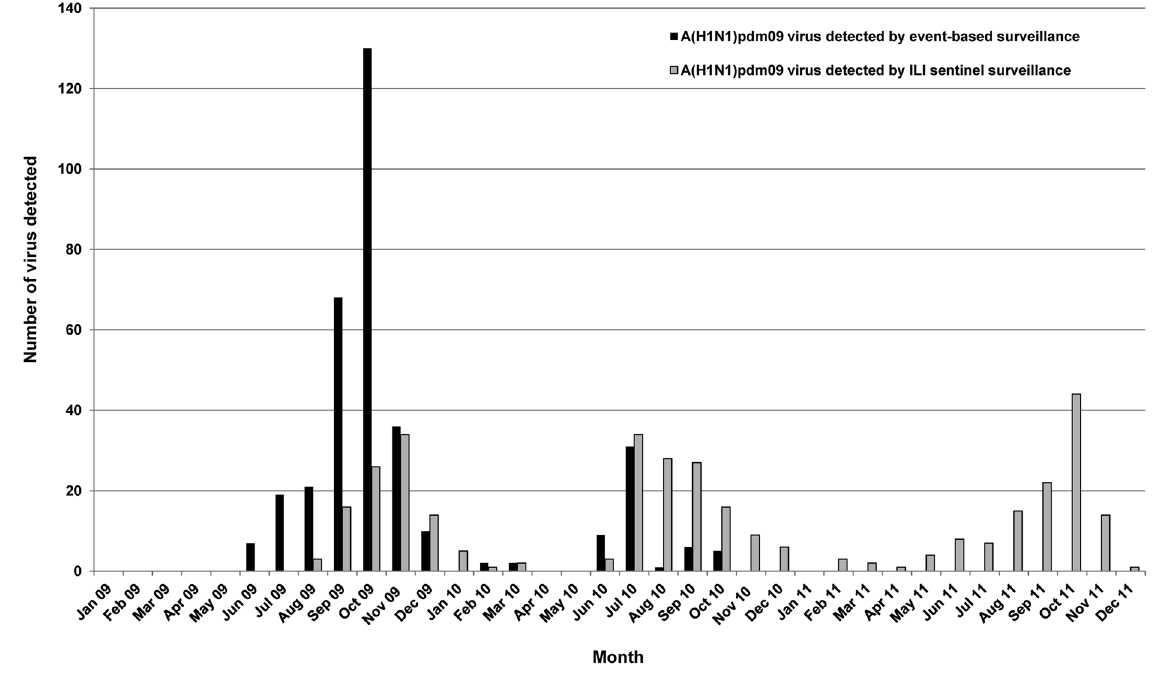
Figure 2. Monthly distribution of H1N1pdm09 virus detected from 2009 to 2011.